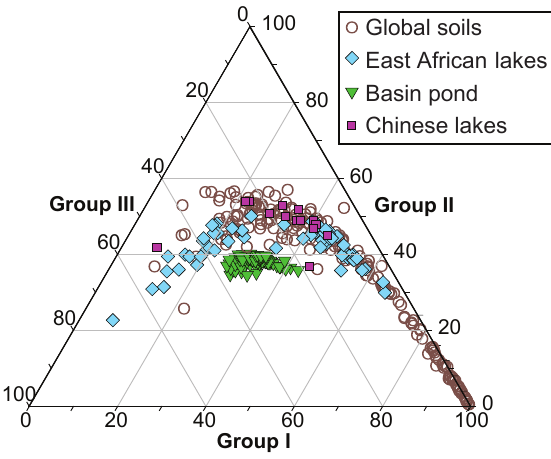
Figure 8. Ternary diagram of brGDGT distributions of lake sedi- ments (Dang et al., 2018; Russell et al., 2018) and global soils (De Jonge et al., 2014a) and Basin Pond